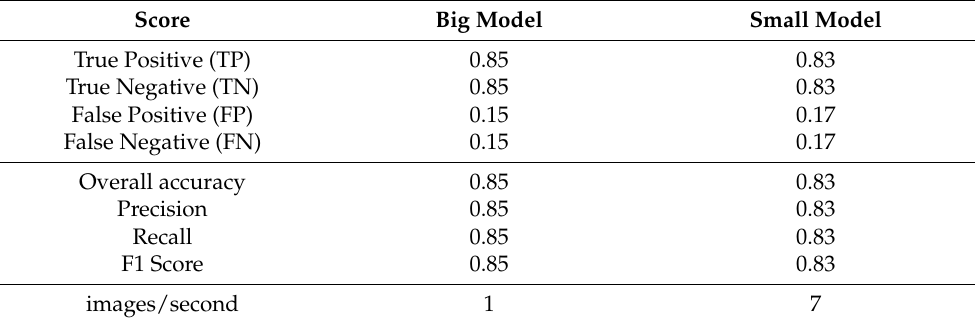
Table 9. Performances comparison considering the big and the small models (in details). Score Big Model Small